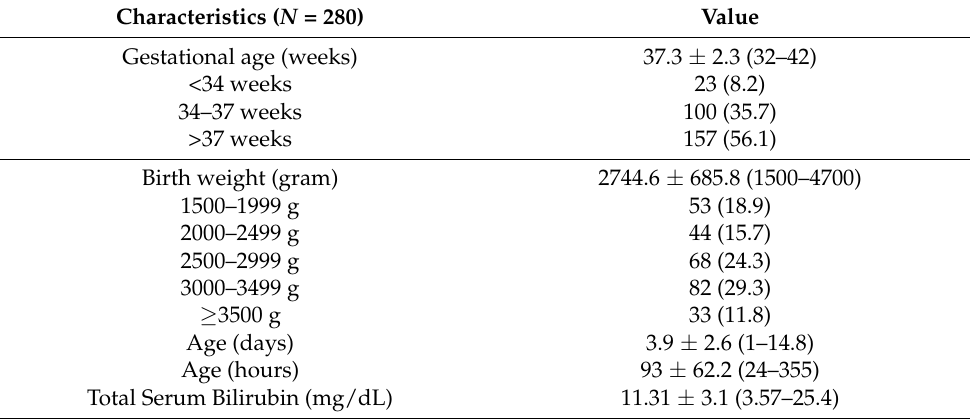
Table 1. Clinical characteristics of